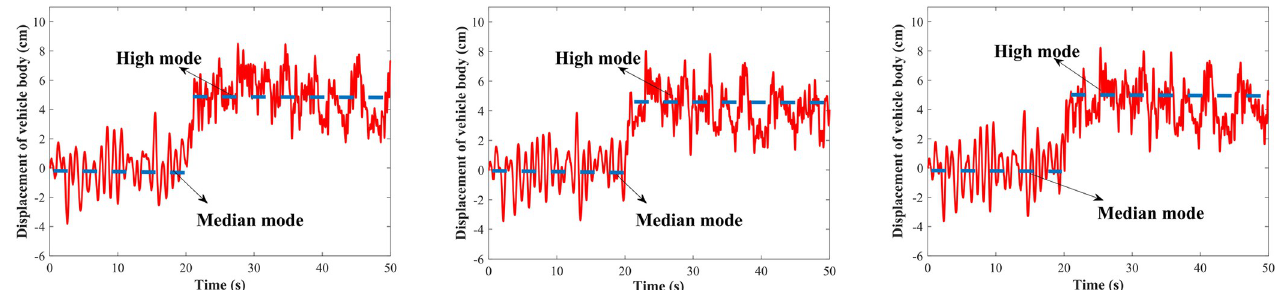
Fig 18. Median mode to high mode under the random road. (A) 20 m/s; (B) 30 m/s; (C) 40 m/s.